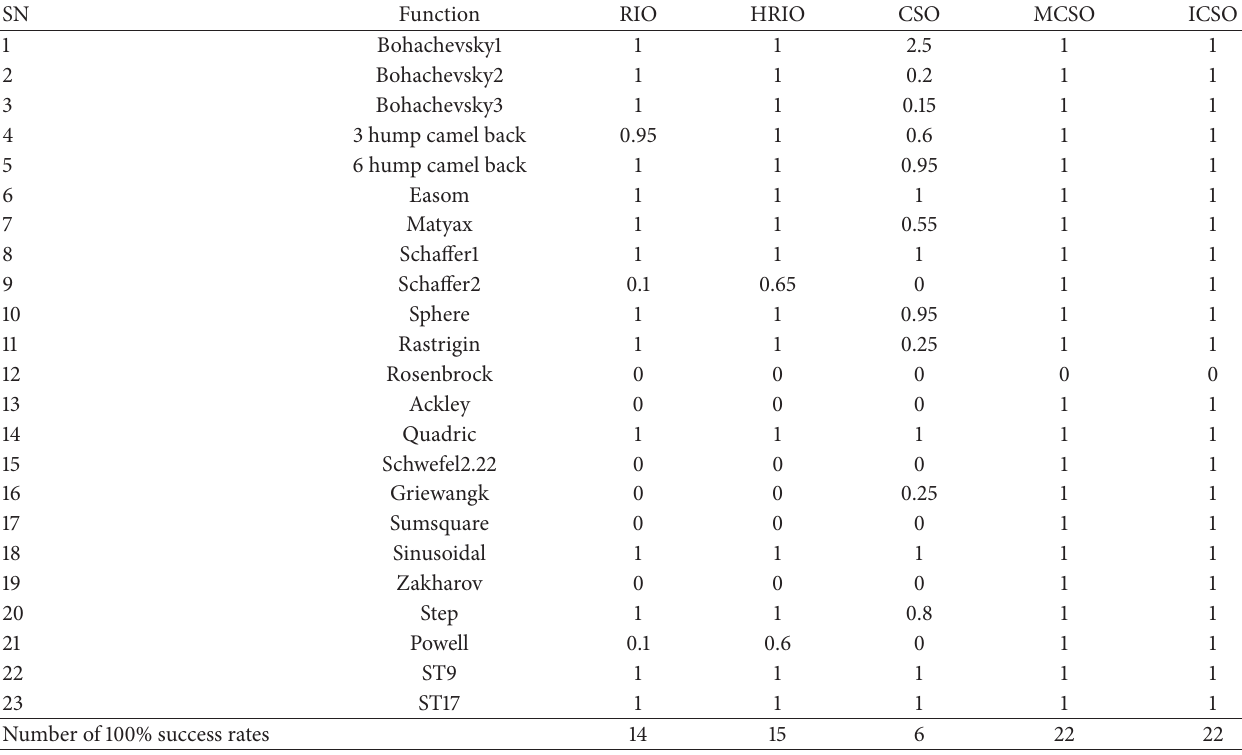
Table 8: Comparison of success performance of RIO, HRIO, CSO, MCSO, and ICSO.